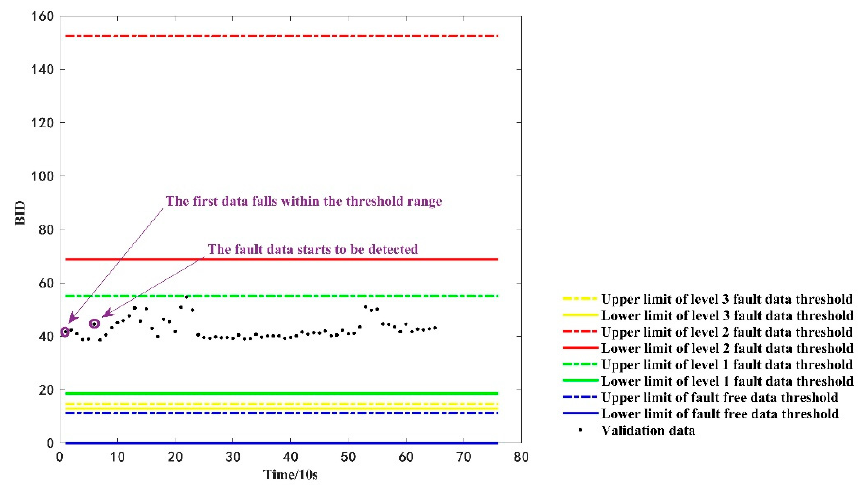
Figure 10. The discrimination results of the verified failure data.